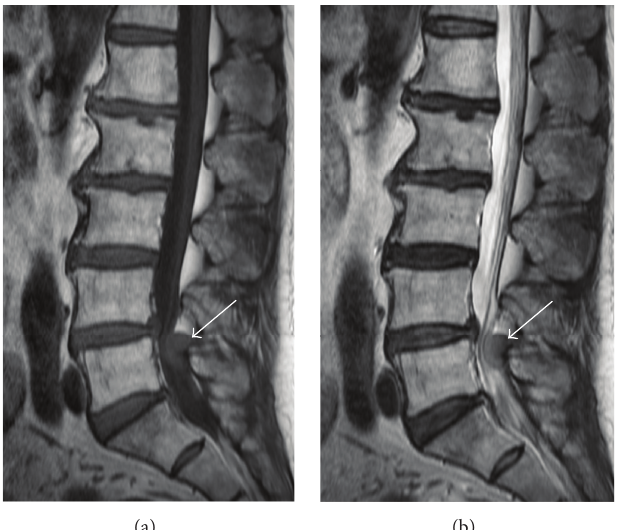
Figure 1: Sagittal T1-weighted MR image (a) and sagittal T2-weighted MR image reveal solitary spinal epidural mass (arrow) showing slightly high signal intensity as compared with signal intensity of skeletal muscle.